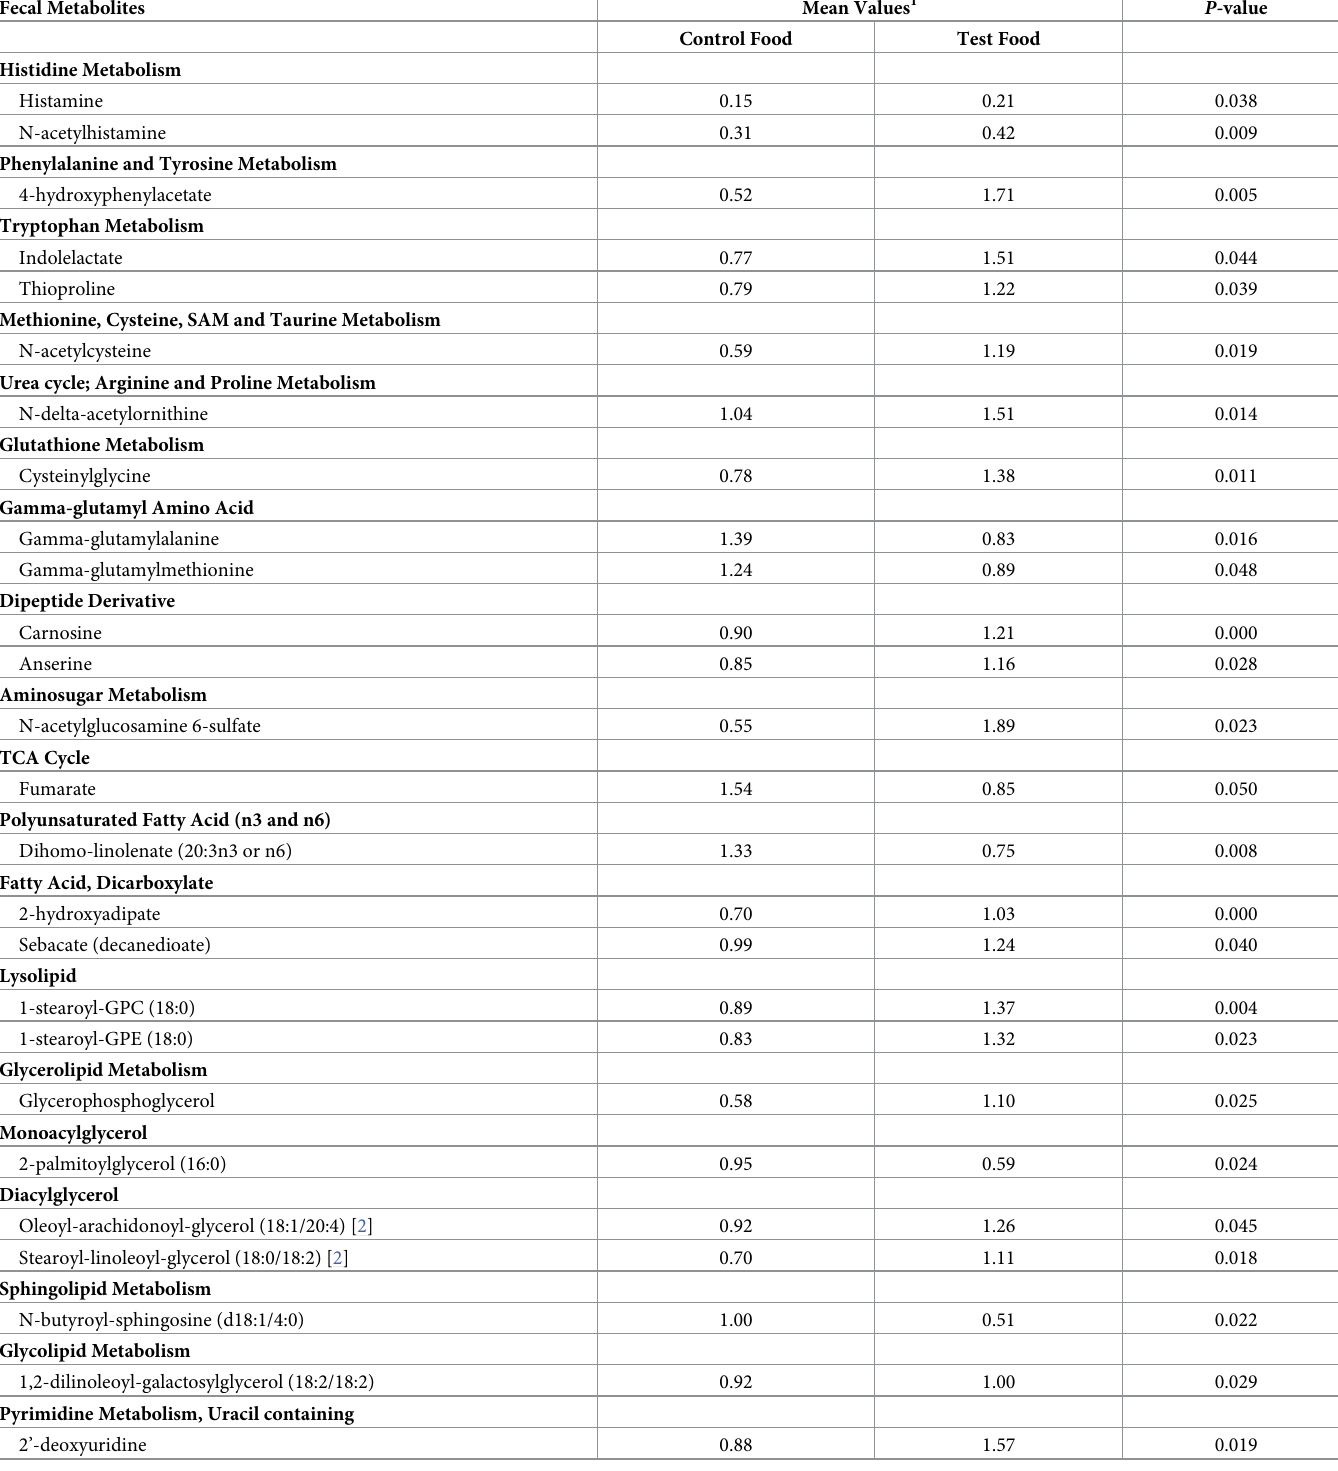
Table 6. Relative concentrations of fecal metabolites that were significantly different ( P � 0.05) in cats with Chronic Kidney Disease (CKD) after feeding control food or test food for 8 weeks in a crossover feeding trial (N =